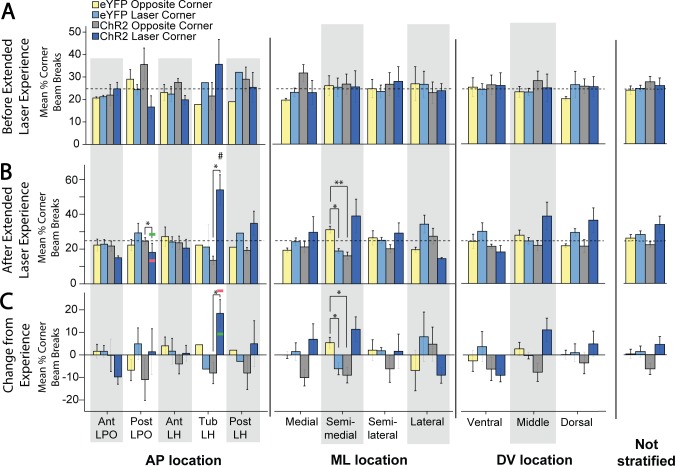
Place-based laser self-administration comparison between groups.These data depict percent of entries into laser-delivering corner compared to alternative corners, comparing ChR2 rats versus eYFP control rats. These data are subdivided into AP, ML, or DV axis levels, or presented for entire LH group combined. A: Corner preferences prior to extended laser exposure. B. Corner preferences after extended laser experience. C: Changes in corner preferences due to extended laser exposure. *: p < 0.05; **: p < 0.01; #: comparison of tLH ChR2 laser corner preference after vs before extended later experience, p < 0.05; green and pink horizontal bars represent male and female mean scores in that group.